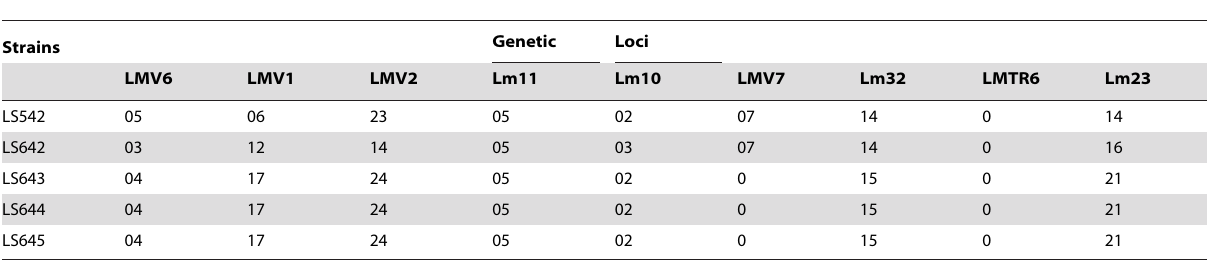
Table 3. The MLVA profiles of the L. monocytogenes strains.